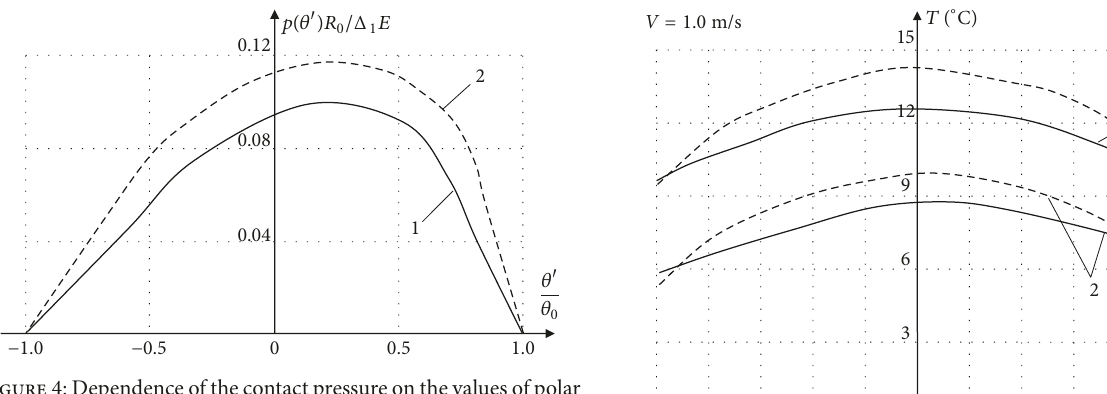
Figure 4: Dependence of the contact pressure on the values of polar angle for 𝑉 = 0.5 m/s.